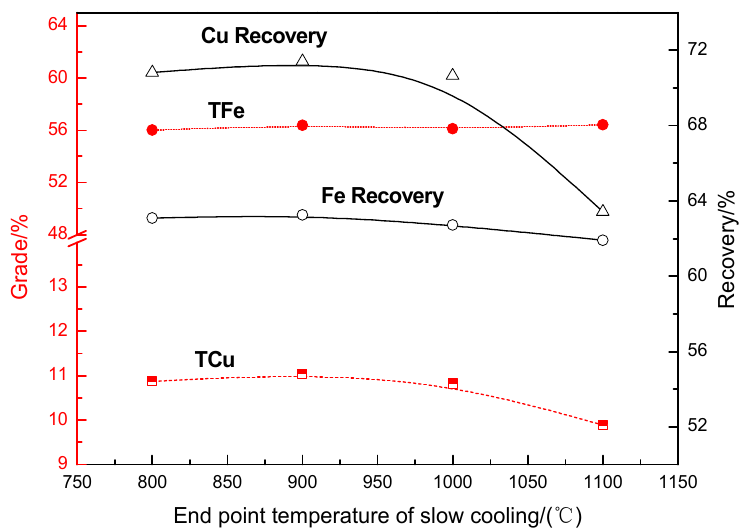
Figure 9. Effects of end point temperature of slow cooling on the recovering of copper and iron (0.45 of binary basicity, blending with 12% of compound additive, modifying at 1350 °C for 120 min and cooling at 1.5 °C/min).